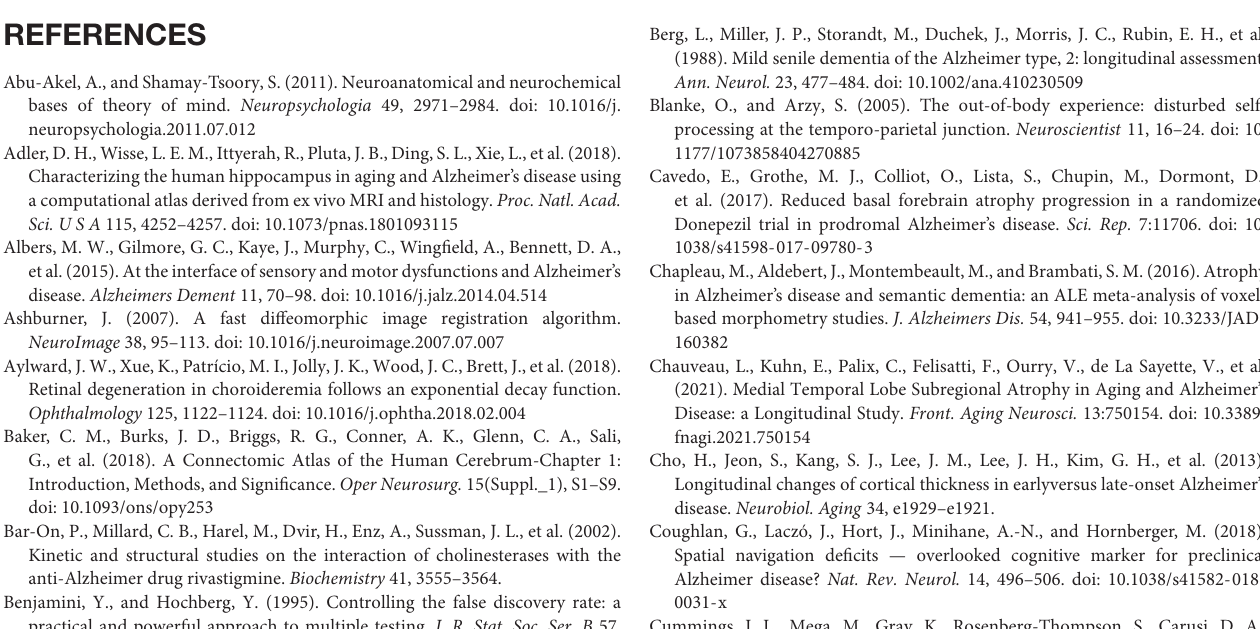
Supplementary Figure 1 | Histogram of p -values from individual t -test for longitudinal VBM. The distribution of p -values from longitudinal VBM peaked for small p -values but did not show a plateau for larger p -values. With this, not all requirements for Storey-Tibshirani multiple testing correction method (Storey and Tibshirani, 2003) were fulfilled. Hence, Storey-Tibshirani correction was comparably pessimistic as Benjamini and Hochberg (1995) multiple testing correction. Supplementary Figure 2 | Histogram of p -values from individual t -test for longitudinal SBM. The distribution of p -values from longitudinal VBM peaked for small p -values and showed a plateau for larger p -values. Moreover, the 360 individual p -values from individual tests allowed for a small bin size for an accurate resembling of the distribution. With this, all preconditions for Storey-Tibshirani approach (2003) are fulfilled and more ROI comparisons remain significant after multiple testing correction. Supplementary Table 1 | Demographic tabular listing with APOE genotypes. For each subject, the table lists two rows, one per session (Screening and Year 1), with columns Age Range, Age, Sex, Diagnosis, MMSE scores, APOE A1 and A2, CDR GLOBAL score, FAQ TOTAL score, NPI TOTAL. Values for ABETA40, ABETA42, PTAU and TAU are available for some subjects but overall largely incomplete and are therefore excluded from any statistical assessment. Supplementary Table 2 | 360 Regions of Interests as defined by the HCP MMP 1.0 atlas. Each row contains the abbreviation and full name for each ROI as well as hemisphere and a part of information derived from neurosurgical literature (Baker et al.,